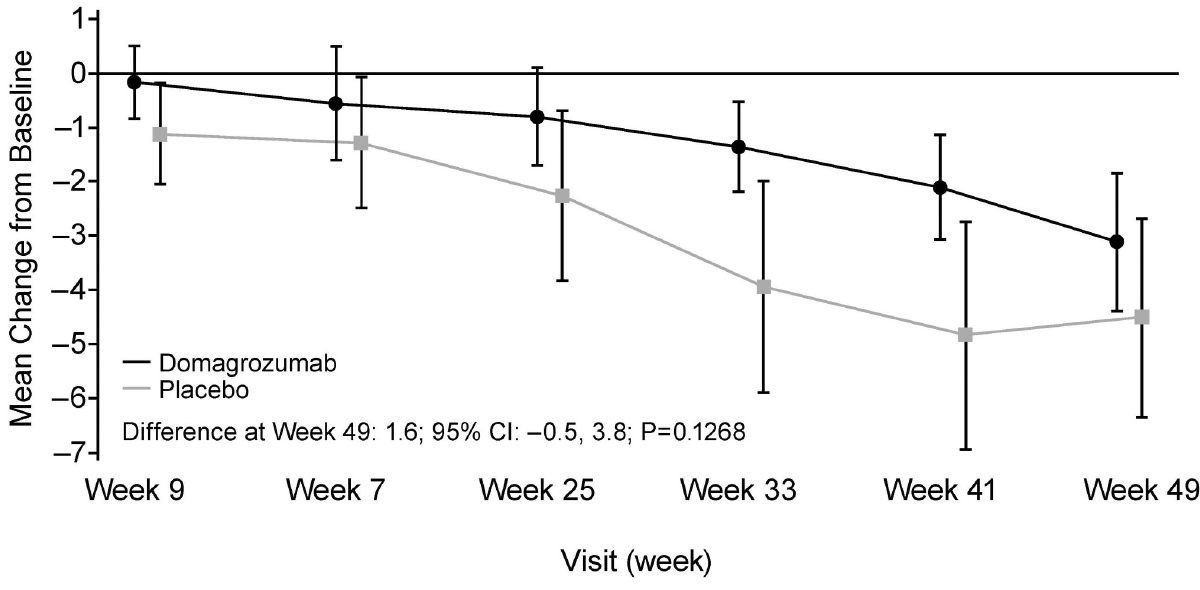
Fig 2. Mean change from baseline in NSAA total score by treatment sequence (full analysis set a ). Sequence 1 : Domagrozumab dose escalation (5, 20, 40 mg/kg) in first 48 weeks followed by domagrozumab 40 mg/kg in weeks 49–96. Sequence 2 : Domagrozumab dose escalation in first 48 weeks followed by placebo in weeks 49–96. Sequence 3 : placebo in first 48 weeks followed by domagrozumab dose escalation in weeks 49–96. a all patients who were randomized and received at least one dose of study drug. NSAA, North Star Ambulatory Assessment.